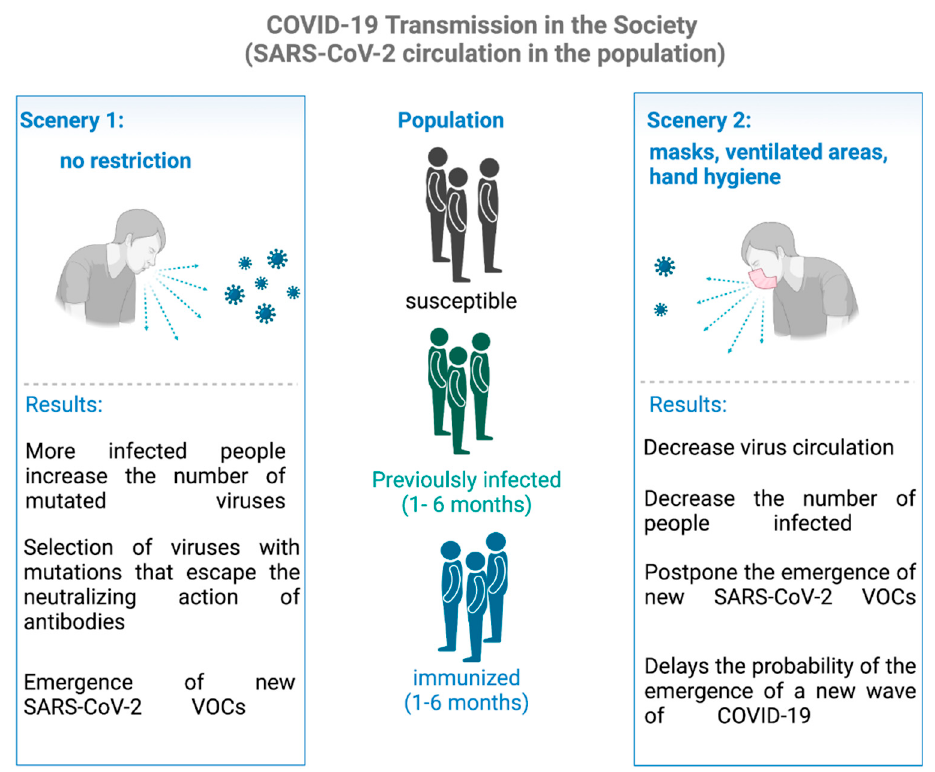
Figure 4. Hypothesis to explain the emergence of novel SARS-CoV-2 variants. Currently, the world population is composed of three groups: those who do not have neutralizing antibodies to fight infection by the virus (susceptible) and those who acquired it either because they were infected by the virus or because they had taken the vaccine. In scenario 1, in which society does not make any kind of restriction to prevent the spread of the virus, the emergence of VOC should occur faster than in scenario 2, in which society maintains measures to reduce the virus spread. These two scenarios are independent of population immunization, since the virus mutates its genetic information randomly, and selection for variants with more successful infection should prevail in the population. This natural selection seems to be directed towards variants that are able to evade the immune system and spread the virus faster. The SARS-CoV-2 neutralizing antibodies of completely immunized and previously infected individuals kept high until 6 months after immunization or virus infection [152].